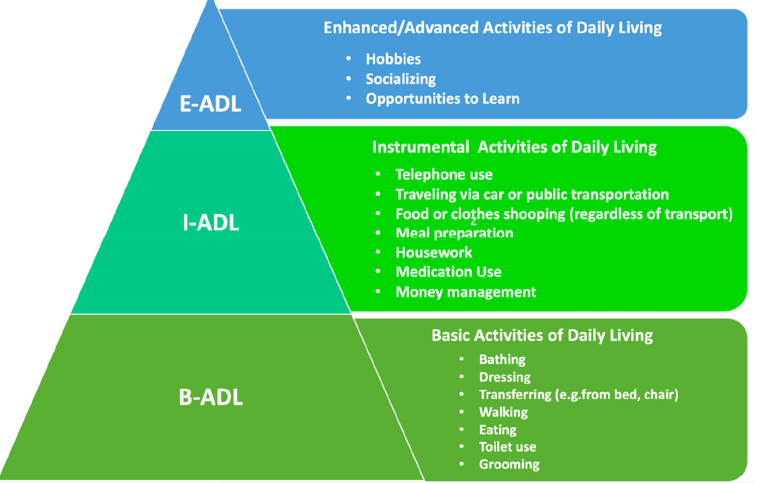
Figure 1. Framework adapted from Czaja et al. p. 257 [29] and De Vriendt et al. [30]. Source: devel ‐ oped by the authors.